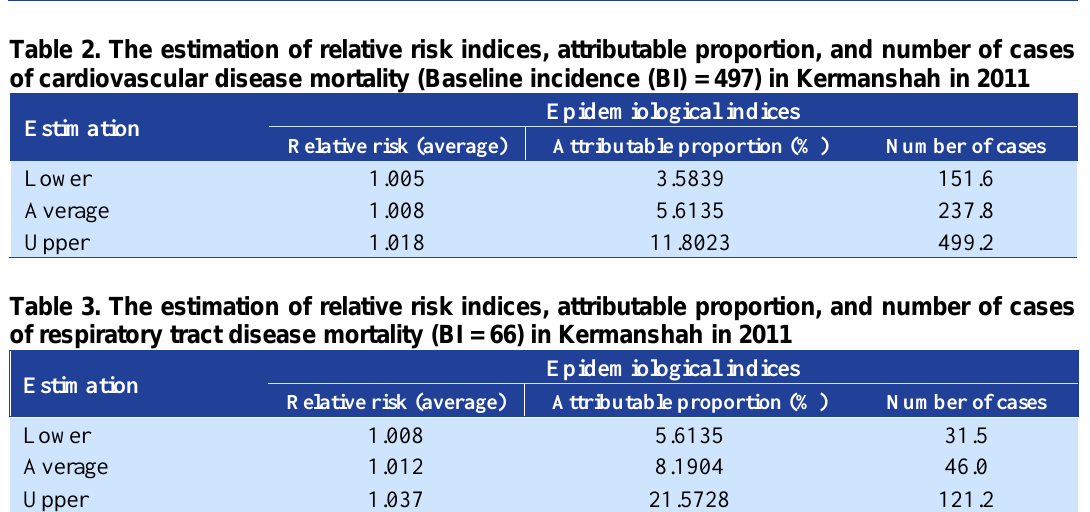
(µgm -3 ) in 3 studied stations in 10